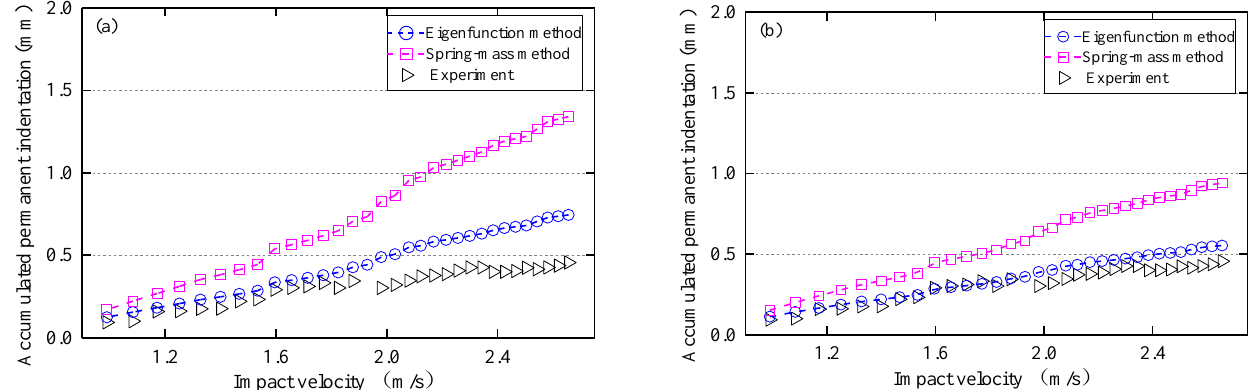
As shown in Figure 13a,b, the accumulated permanent indentation of the last impact for every impact velocity are analyzed. The accumulated permanent indentations pre- dicted by eigenfucntion expansion method and spring-mass method are compared with the experimental results. The plots show that the accumulated permanent indentation pre- dicted by eigenfucntion expansion method agree well with experimental results than spring-mass method. It means that the wave propagation has obvious influence on the accumulated permanent indentation of repeated impacts. Figure 13a,b shows that the ac- cumulated permanent indentation predicted by eigenfucntion expansion method is max- imally 44.46% and 69.97% less than those predicted by spring-mass method for UC model and MYC model, respectively. It means that by using different local contact models, large discrepancies can be obtained on simulating impact behaviors of eigenfunction expansion method. This demonstrates the importance of selecting appropriate local contact models. Figure 12. Comparison of impact duration: ( a ) Hertz model; ( b ) ML model. Figure 12. Comparison of impact duration: ( a ) Hertz model; ( b ) ML model.